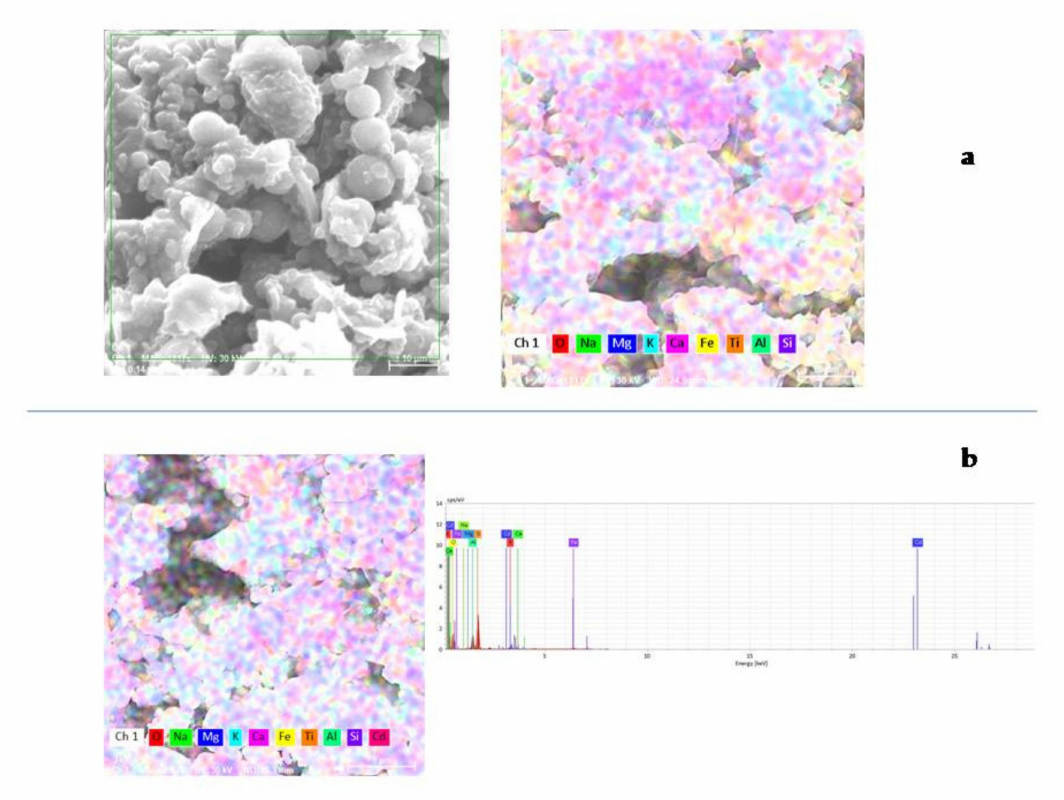
Figure 2. Elemental analysis by EDX for FA / H 2 SO 4 ( a ); FA / H 2 SO 4 + Cd 2 + ( b ).